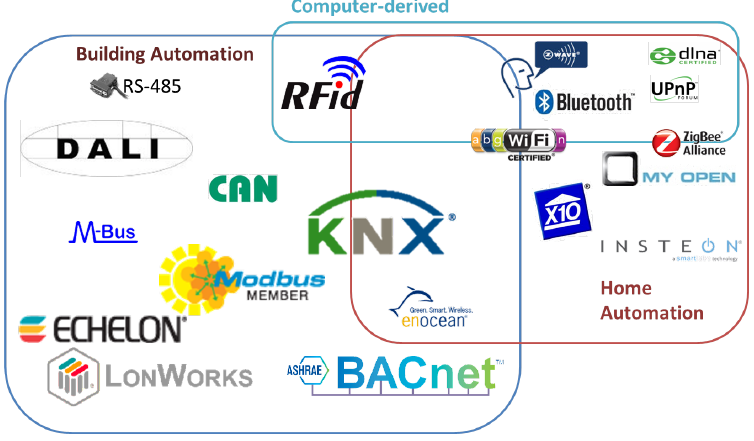
Figure 2. Some commonly adopted building automation